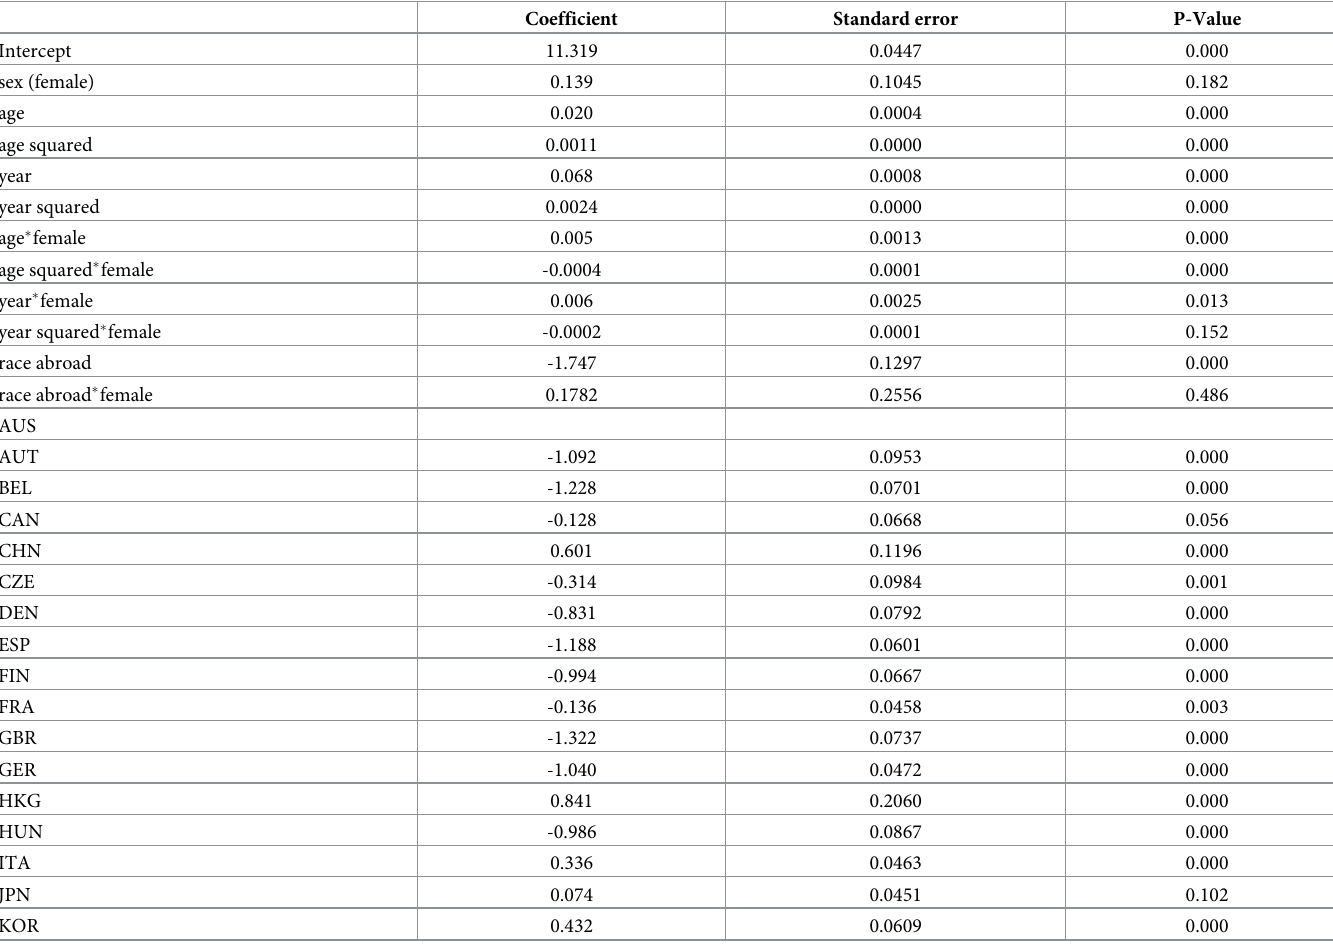
Table 14. Interaction with race site, results from linear regression with truncated dataset time = sex × (year+year 2 )+sex × (age+age 2 ) + sex × nationality × site and refer- enced to male, age 44, year 2009, site at home and nationality Australia. R 2 =